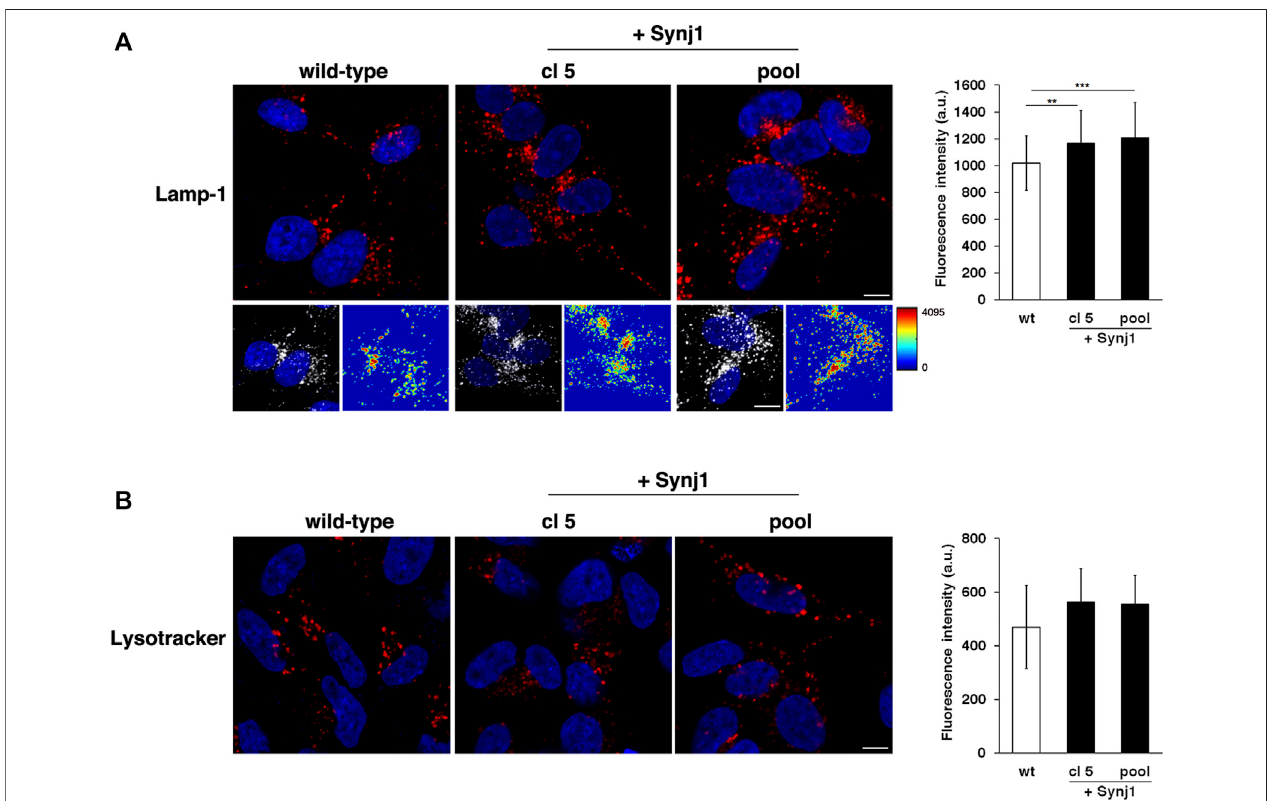
FIGURE10| Synj1 overexpression affects the homeostasisoflysosomal compartment in SH-SY5Y cells. (A) Immuno fl uorescence assaysusing Lamp-1 antibody in wild-type and Synj1-overexpressing SH-SY5Y cells, carried out as in Figure 8A , are shown. Serial confocal sections were collected from the top to the bottom of the cells. The 3D reconstruction and corresponding intensity map are shown. Scale bars, 8 μ m. The bars show the relative mean value ± SD of three independent experiments, n ≥ 50cells. (B) Lysosomesofwild-typeandSynj1-overexpressingSH-SY5YcellswerelabelledwithLysoTrackerdyeasin Figure8E .Serialconfocal sections are shown; scale bars, 8 μ m. The bars show the relative mean value ± SD of three independent experiments, n > 40 cells. ** p < 0.01, *** p < 0.001, Student ’ s t